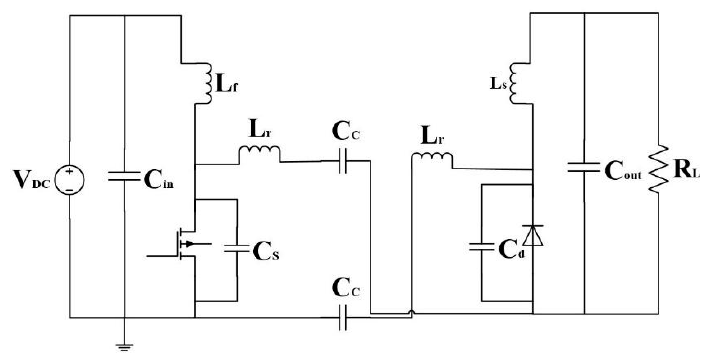
Figure 2. Class-E 2 converter with compensation network.